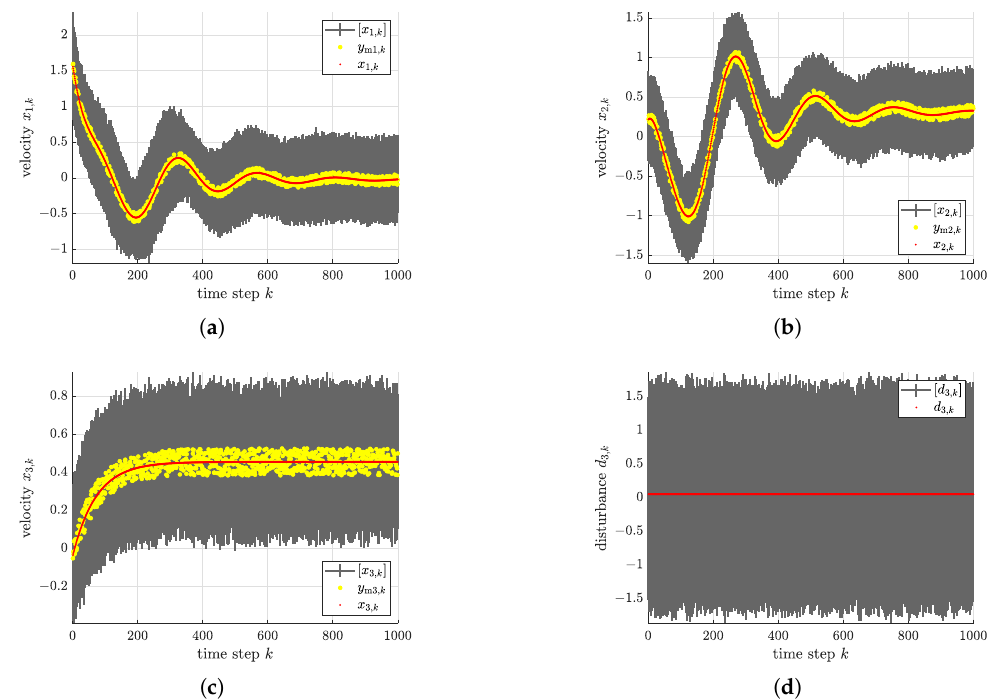
Figure 12. Comparison of the estimation results with noisy measurements and true system states for (cid:2) (cid:3) x 1, k the case of large uncertainties (91). ( a ) Estimated bounds vs. measured and true velocities y m1, k (cid:2) (cid:3) x 2, k and x 1, k . ( b ) Estimated bounds vs. measured and true velocities y m2, k and x 2, k . ( c ) Estimated (cid:2) (cid:3) x 3, k bounds vs. measured and true velocities y m3, k and x 3, k . ( d ) Estimated bounds disurbance d 3, k = 0.05.